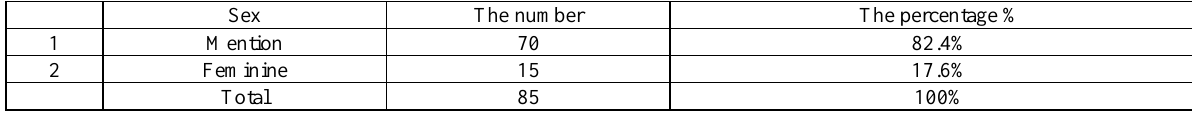
Table 2. Distribution of members of the study sample on sex